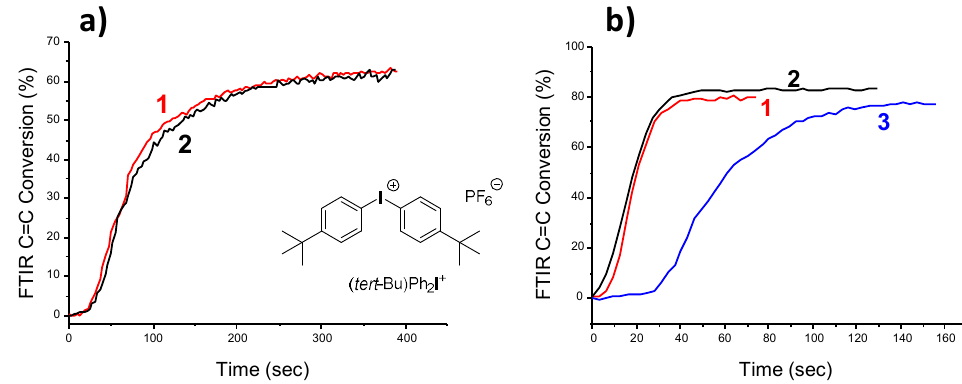
Figure 24. ( a ) Comparison of the polymerization profiles obtained for the FRP of the methacrylates resin using Cu-2 .PF 6 prepared by mechanochemistry (1) and Cu-2 .BF 4 in solution (2) in two-component Cu-2 / ( tert -Bu)Ph 2 I + (0.3% / 0.8% w / w ) systems upon exposure to a LED at 405 nm (35 mW / cm 2 ). ( b ) Comparison of the polymerization profiles obtained with two-component Cu-2. PF 6 / ( tert -Bu)Ph 2 I + (0.3% / 0.8% w / w ) systems upon exposure to a LED at 405 nm (110 mW / cm 2 ) using (1) mechanosynthesized Cu-2. PF 6 , (2) solution-synthesized Cu-2 .BF 4 , (3) using the three-component mechanosynthesized Cu-2. I / ( tert -Bu)Ph 2 I + / Tin (II) (0.3% / 0.8% / 5% w / w / w ) Reproduced with permission from the work in [104]. Copyright 2018 American Chemical